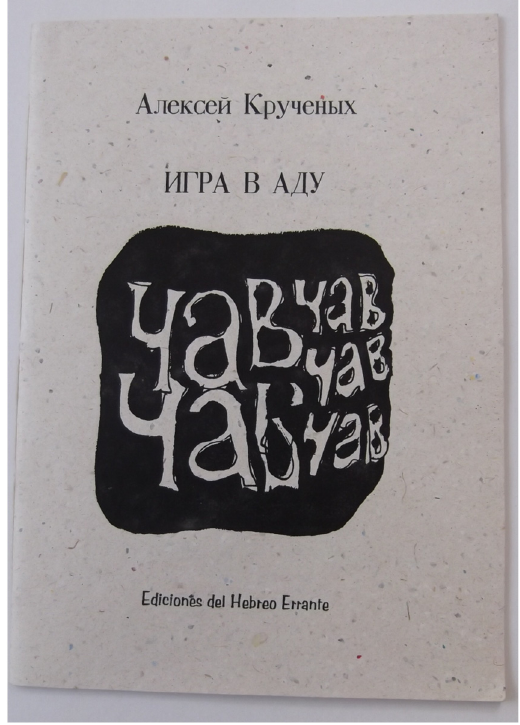
Figure 11. Cover of ‘Igra v adu’.